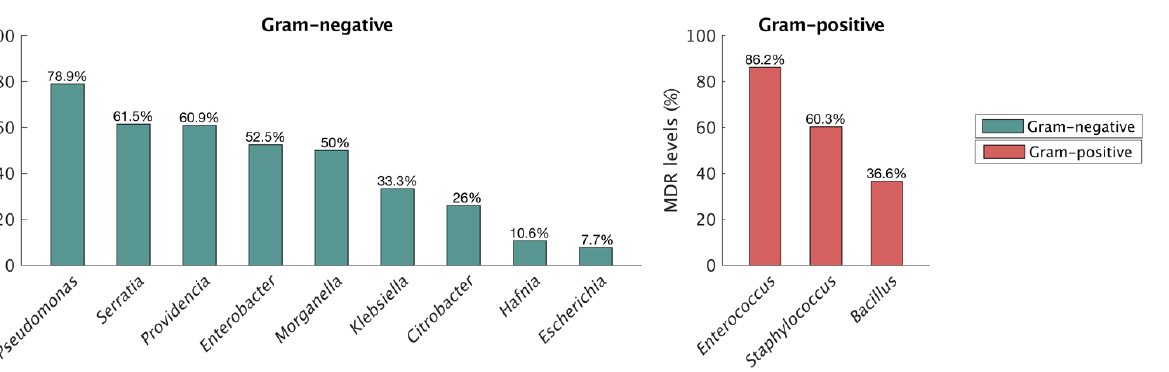
Figure 2. Percentage of multi-drug-resistant (MDR) strains in Gram-negative ( left panel) and Gram- positive ( right panel) bacterial genera.